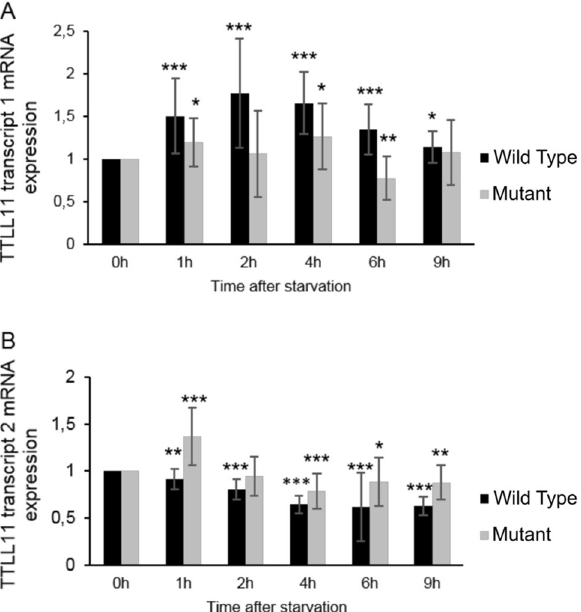
Figure 2. WT and mutant TTLL11 mRNA expression after starvation. WT (DE0194) and mutant (DE0193) fibroblasts were treated with medium without FBS for different times. Cells were then processed for mRNA isolation and the relative mRNA expression of both transcript 1 ( A ) and 2 ( B ) of TTLL11 at different time point after serum starvation were determined by qPCR. The levels of mRNAs were plotted relative to cells harvested at 0 h (n = 3). Error bars represent SD. The difference between one independent group and the control group 0 h was examined by unpaired, two-tailed Student’s t-test, *P ≤ 0.05, **P ≤ 0.01, ***P ≤